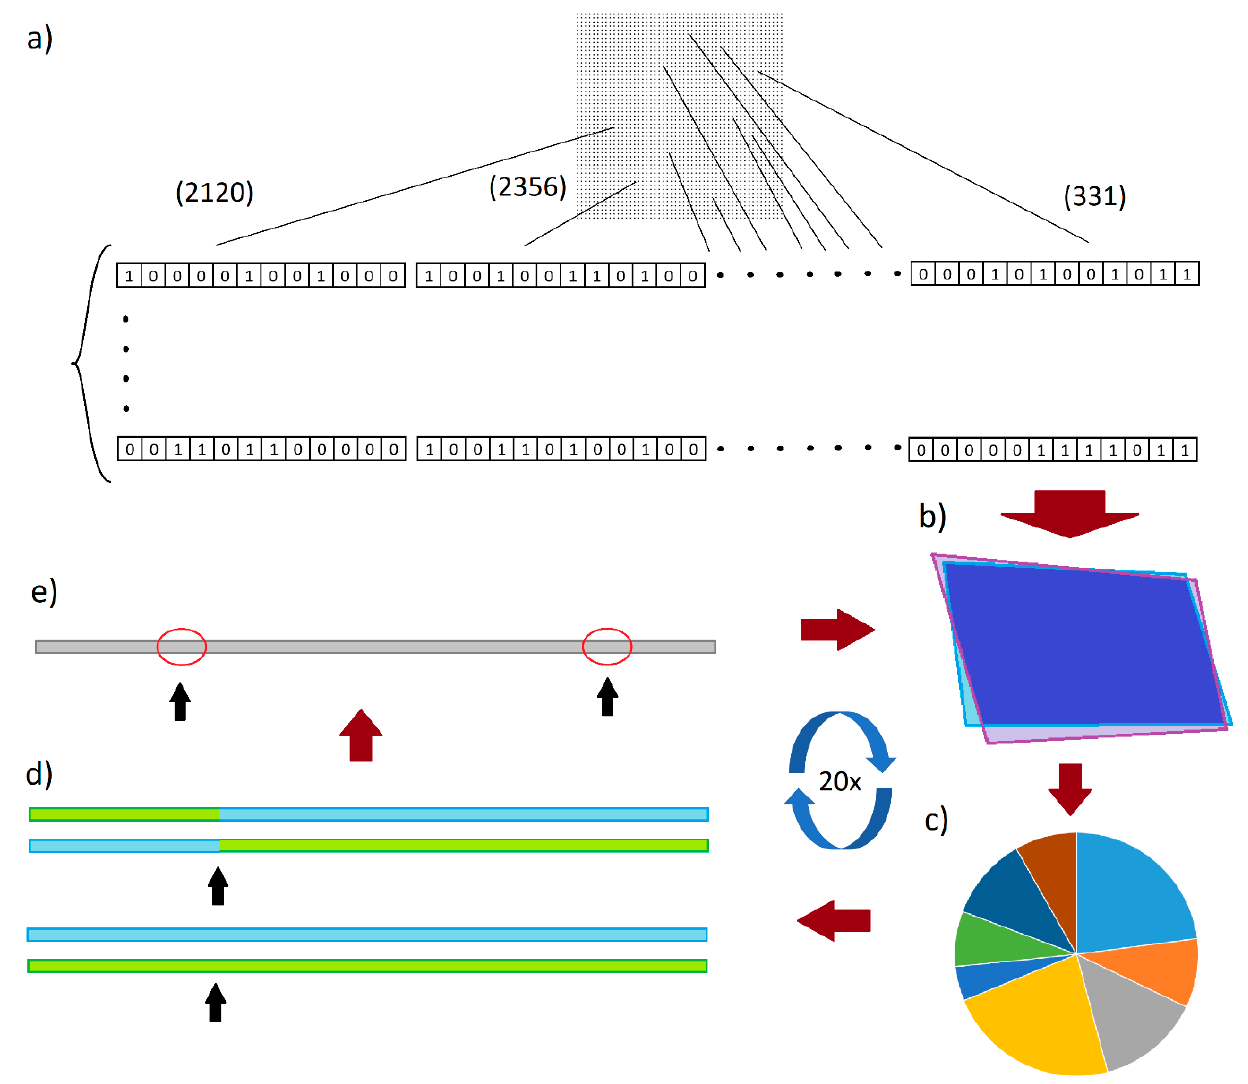
Figure 5. The next steps in the operation of the simple genetic algorithm: ( a ) selection of the initial population; ( b ) assessment of population adaptation; ( c ) selection by roulette method; ( d ) crossing with a randomly selected split point (locus); ( e ) mutation of a randomly selected gene.